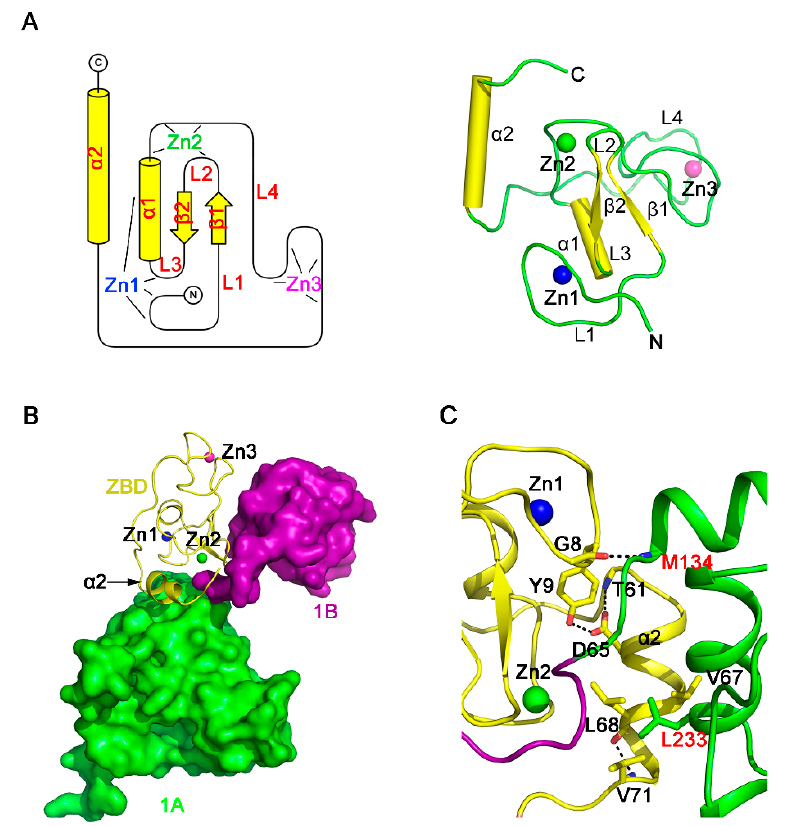
Figure 3. Structural characterization of the PRRSV nsp10 ZBD. ( A ) The topology ( left ) and ribbon model ( right ) of the ZBD. ( B ) Overview of the spatial orientation of the helix α 2 of ZBD. Domains 2A and CTD are omitted for clarity. ( C ) Close-up view of the domain interface between ZBD and domain 1A. Residues engaged in interactions are shown as sticks. Domain colors are the same as in Figure 1A.